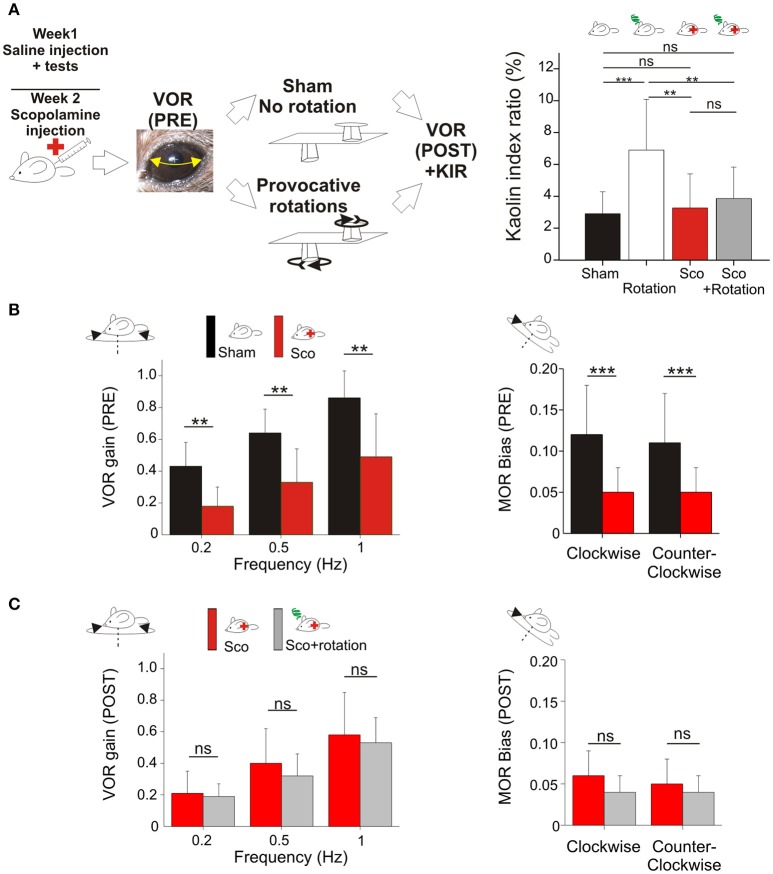
(A) Scopolamine protects against motion sickness. Left panels, animals already tested with saline received scopolamine injection; VOR was tested before and after a Sham experiment and a provocative double-rotation experiment. Right, Pica behavior demonstrated the protective effects of scopolamine against motion sickness. (B) Scopolamine reduces vestibular sensitivity. Left, plots of angular VOR gain show significant reduction at all tested frequencies before provocative stimulation (Pre measurements). Right, plots of MOR bias shows significant reduction under scopolamine treatment. (C) No additional reduction of vestibular sensitivity was observed following provocative rotation protocol (Post measurements). Left, plots of angular VOR. Right, plots of MOR bias. Asterisks indicate statistically significant differences with Holm-Bonferroni correction, *p < 0.05; **p < 0.01; ***p < 0.001 respectively.